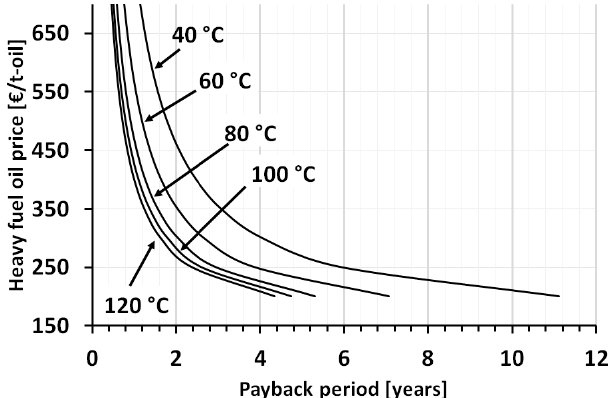
Figure 6. The payback periods for the soot sludge and sawdust mixture dryers when the inlet air temperatures are 40, 60, 80, 100 and 120 °C. All initial values are shown in Table 5. Table 6. The payback period calculations for the base case when the current import price of the heavy